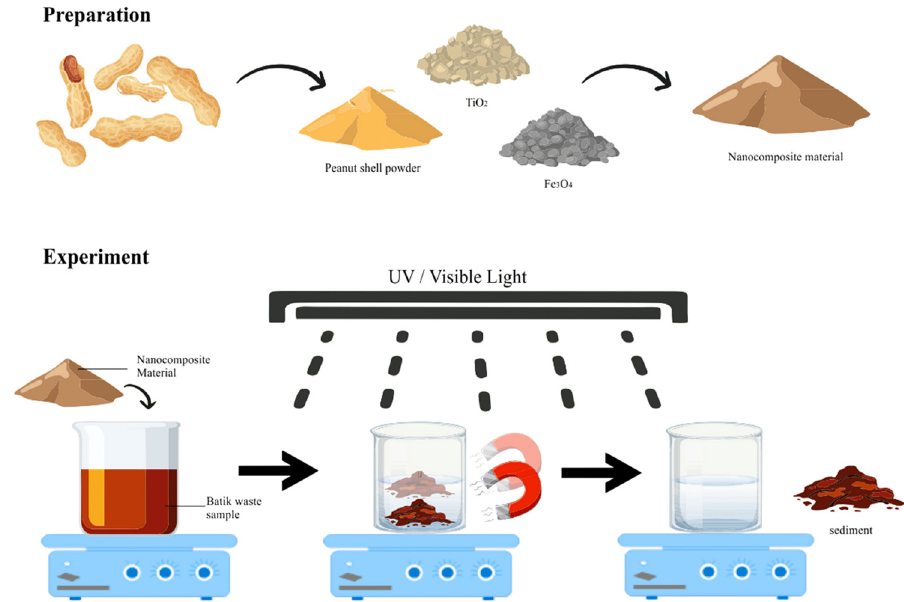
Figure 1: A proposed illustration for synthesis and application of Fe 3 O 4 /TiO 2 /AC.